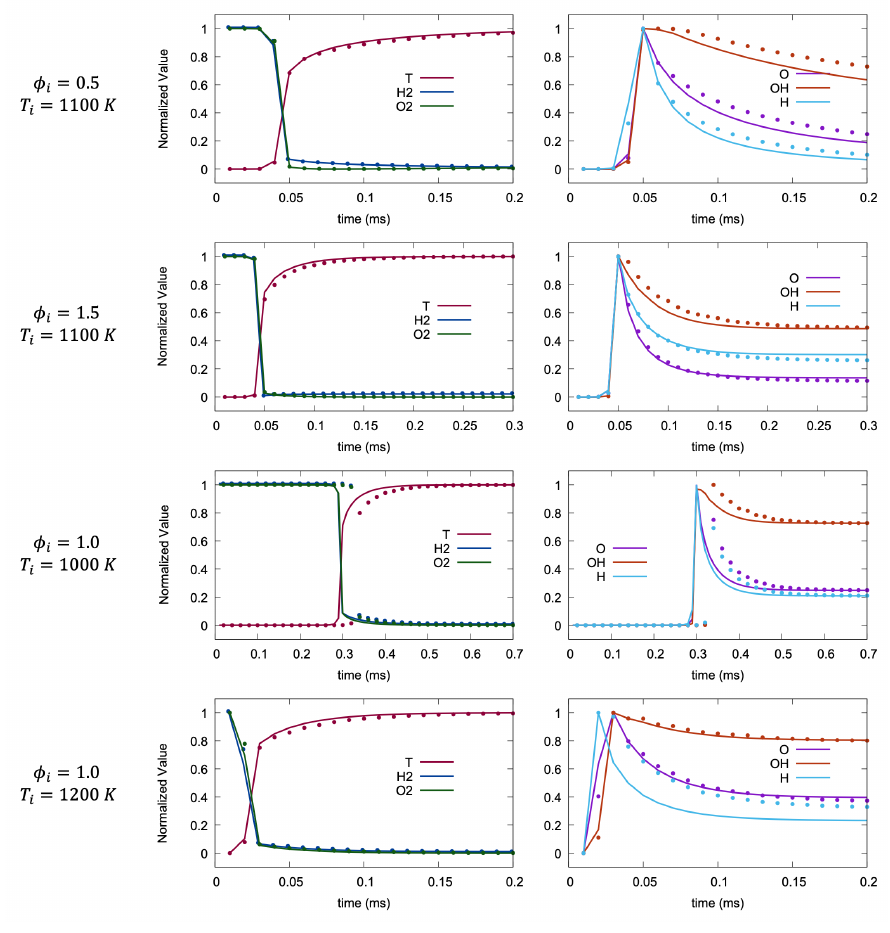
Figure 6. Temporal variation of normalized temperature and species mass fraction at the boundaries of dataset. Solid line and symbols represent OpenFOAM and LIT solution, respectively.